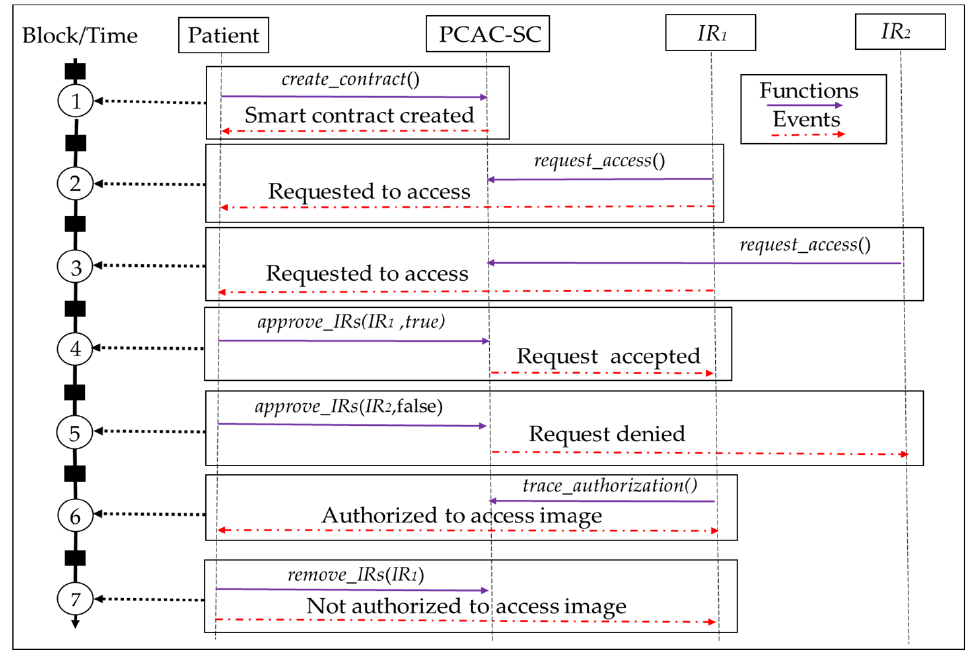
Figure 4. Access sharing sequence. The blockchain/timeline is shown on the left, pointing with dotted arrows for reference. The purple, and red arrows represent interactions between entities.